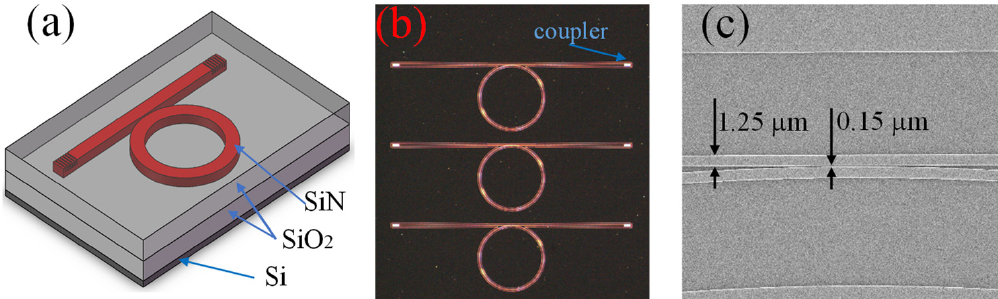
Figure 5. ( a ) The schematic illustration, ( b ) micrograph, and ( c ) SEM image in the coupling region of the micro-ring resonators.